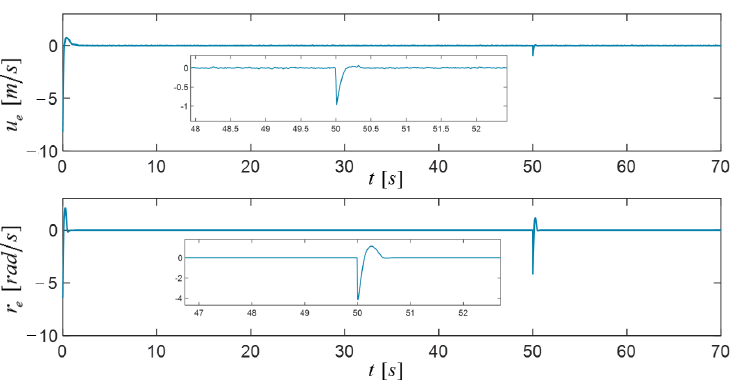
Figure 11. The errors of virtual speed for the proposed method under the influence of TV-C.